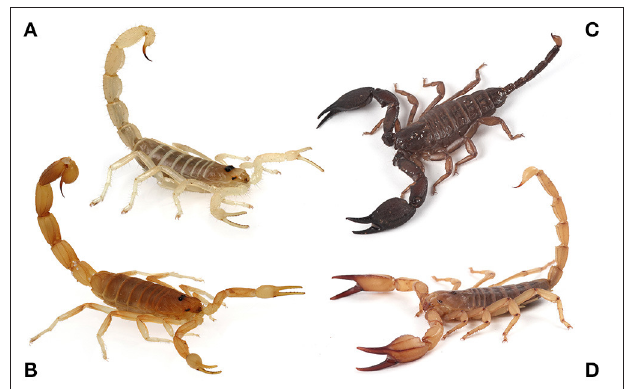
FIGURE 1 | Morphological comparison of four Australian scorpions. (A) Australobuthus xerolimniorum (Buthidae) (B) Lychas buchari (Buthidae) (C) Hormurus waigiensis (Hormuridae) (D) Urodacus sp. (Urodacidae). A. xerolimniorum and L. buchari are more vagrant and active foragers, and have evolved relatively small chelicerae and thick powerful tails. H. waigiensis and Urodacus sp. are burrowing species, and have evolved larger chelicerae and smaller stinging apparatuses. Photographs by Edward